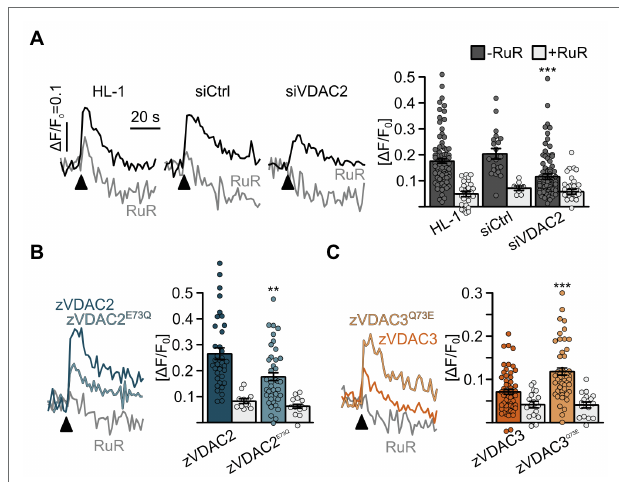
FIGURE 8 | Restoration of SR-mitochondria Ca 2+ transfer in permeabilized HL-1 cardiomyocytes. (A) Knockdown of the endogenous mVDAC2 in HL-1 cells significantly reduced SR-mitochondria Ca 2+ transfer after addition of caffeine (arrowhead) from Δ F/F 0 = 0.18 ± 0.01 ( n = 84) to 0.12 ± 0.01 ( n = 83) while a scrambled siRNA control did not affect Ca 2+ transfer (0.20 ± 0.02, n = 21). (B) Wild-type zVDAC2 restored mitochondrial Ca 2+ uptake to 0.27 ± 0.02 ( n = 36), well above mVDAC2 knockdown cells. Overexpression of zVDAC2 E73Q restored mitochondrial Ca 2+ uptake to only 0.18 ± 0.02 ( n = 39), which is significantly lower compared to wild-type zVDAC2. (C) Conversely, zVDAC3 did not restore mitochondrial Ca 2+ uptake in mVDAC2 knockdown cells (0.12 ± 0.01, n = 54), while VDAC3 Q73E restored mitochondrial Ca 2+ uptake to Δ F/F 0 = 0.20 ± 0.02, ( n = 50). Arrowheads indicate injection of 10 mM caffeine. Statistical analysis was performed using Kruskal-Wallis test with Dunn’s post-hoc